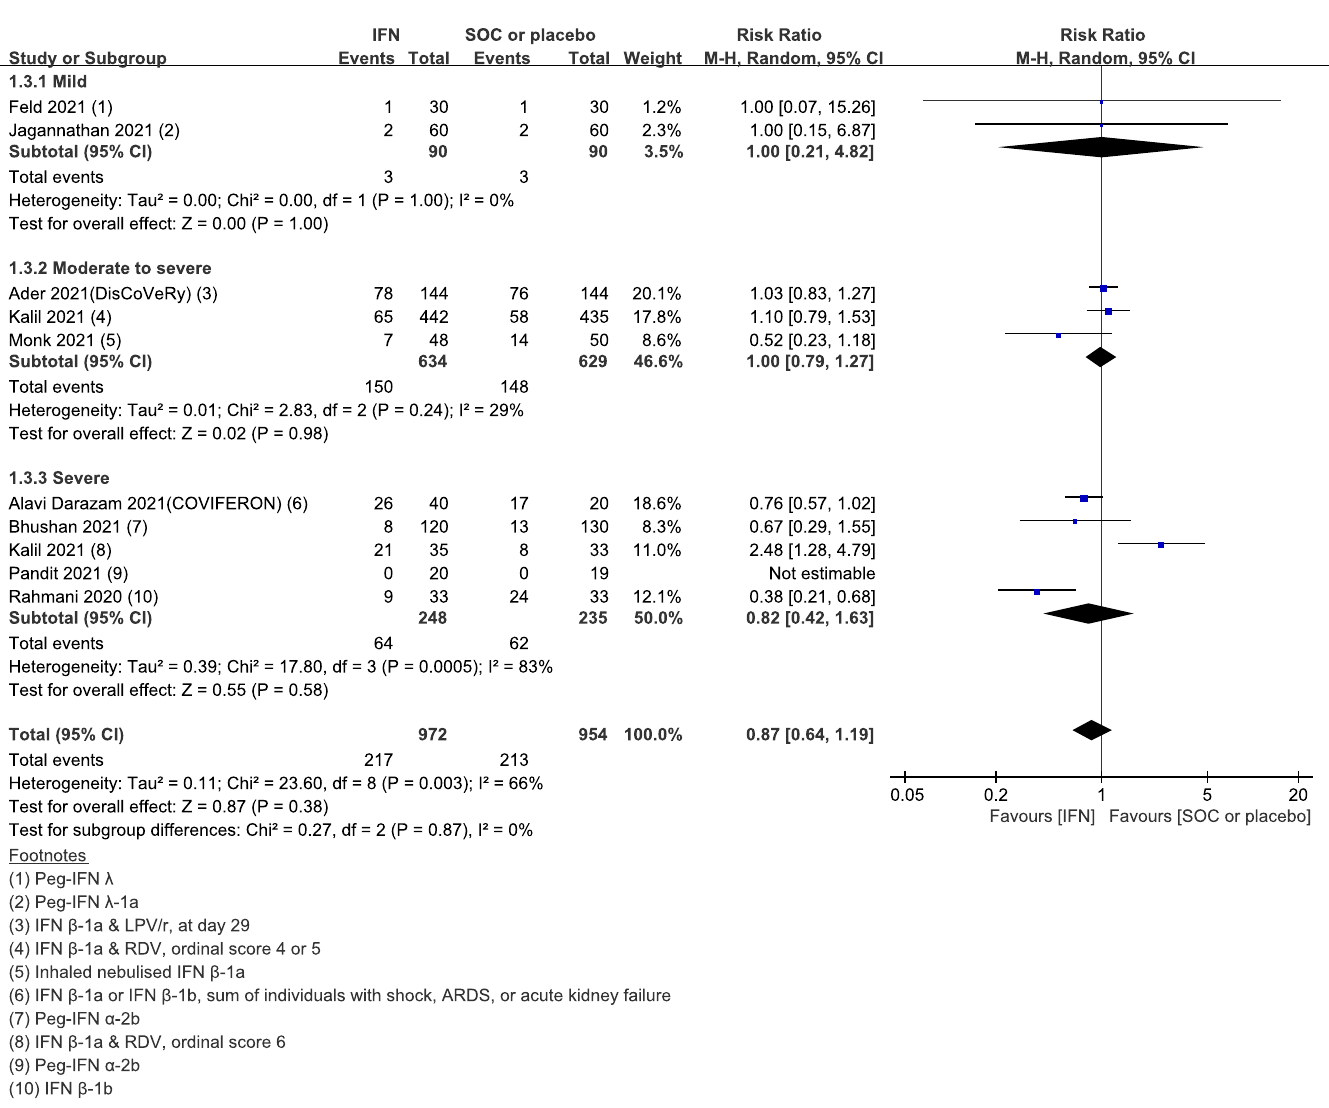
Fig 4. Forest plot of serious adverse events. Forest plot presenting the risk ratio (RR) of serious adverse events between the interferon (IFN)-treated and control arms. Meta-analysis of nine randomized controlled trials (RCTs) comprising 1,926 patients revealed that IFN therapy did not lead to a significant increase in the development of serious adverse events compared to the control arm (pooled RR = 0.87, 95% CI: 0.64–1.19; I 2 = 66%).